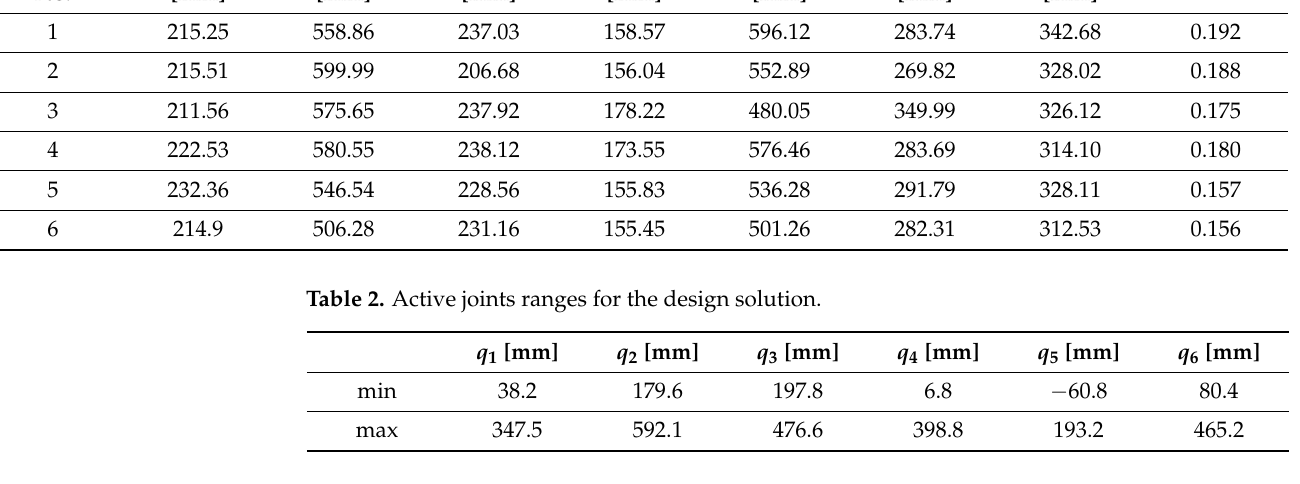
Table 1. Results from the geometric optimization algorithm.